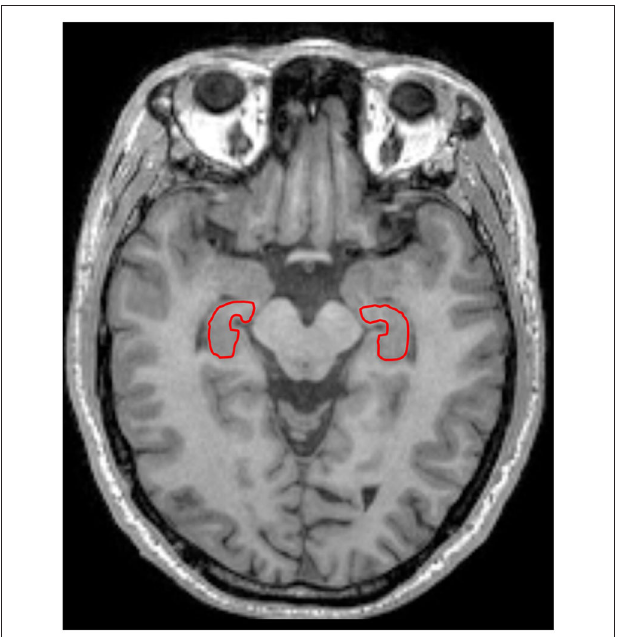
FIGURE 1 | A 67-year-old male healthy control. The left and right hippocampus are outlined in red line in T1-weighted imaging.